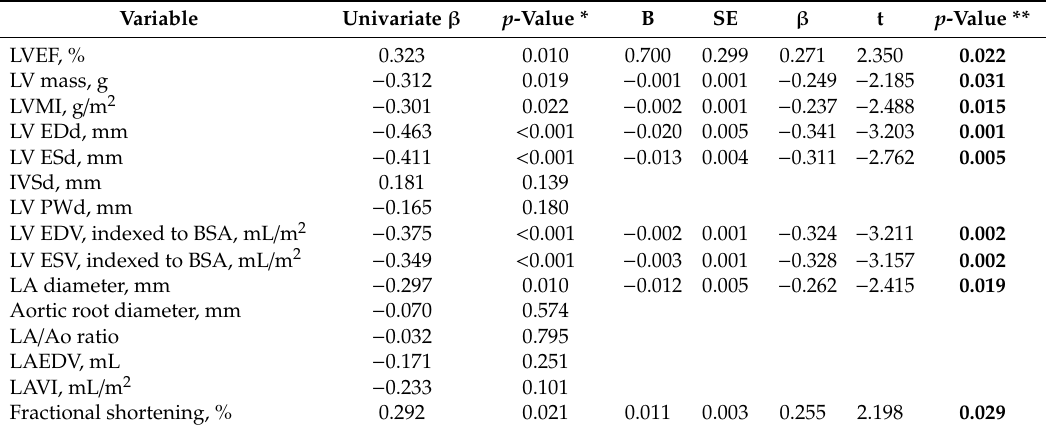
Table 5. Univariate beta estimates and results from multivariable linear regression showing associations of serum CST levels (ng / mL), with echocardiographic